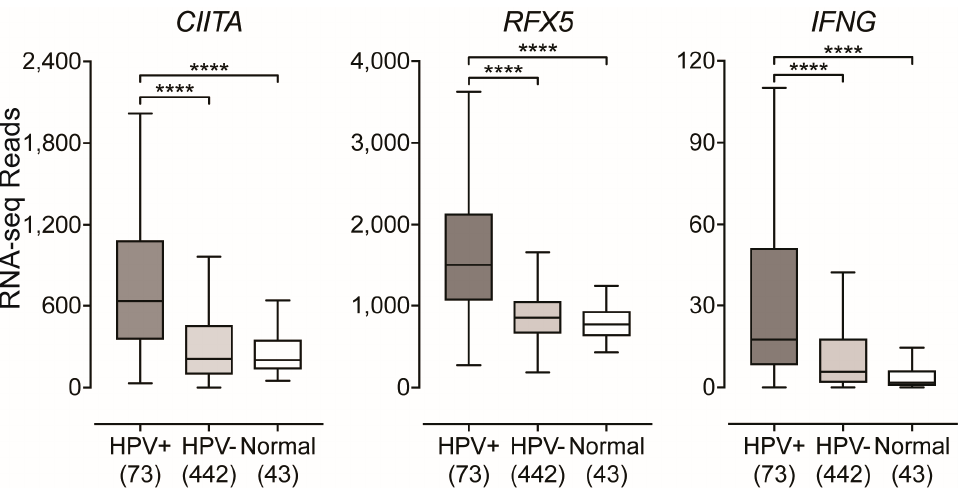
Figure 3. Expression of class II major histocompatibility complex transactivator ( CIITA) , regulatory factor X5 ( RFX5) , and interferon-gamma ( IFNG) mRNA in head and neck carcinomas stratified by HPV-status. RSEM normalized RNA-seq data for the CIITA , RFX5 , and IFNG genes were extracted from the TCGA database for the HNSC cohort for HPV + , HPV − , and normal control tissues. Numbers in brackets refer to the number of samples included in each analysis. Statistical analysis was performed using a two-tailed non-parametric Mann–Whitney U test. ** p ≤ 0.01, *** p ≤ 0.001, **** p ≤ 0.0001, ns—not